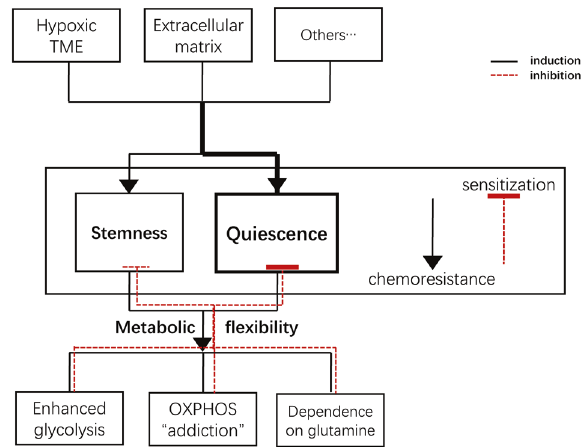
Fig. 3 Flow diagram of quiescent CSCs initiation and their metabolic reprogramming. Quiescent CSCs are induced and maintained by different TME components, including a hypoxic tumor environment, laminins, and matrix stiffness of the ECM and CAFs. Quiescent CSCs can reprogram their metabolism to fl exibly adapt to environmental changes, which is considered crucial for them to enhance the antioxidant compensative capacity and induce chemotherapy resistance. And it is a promising strategy of making them susceptive to chemotherapies through inhibition of their metabolic fl